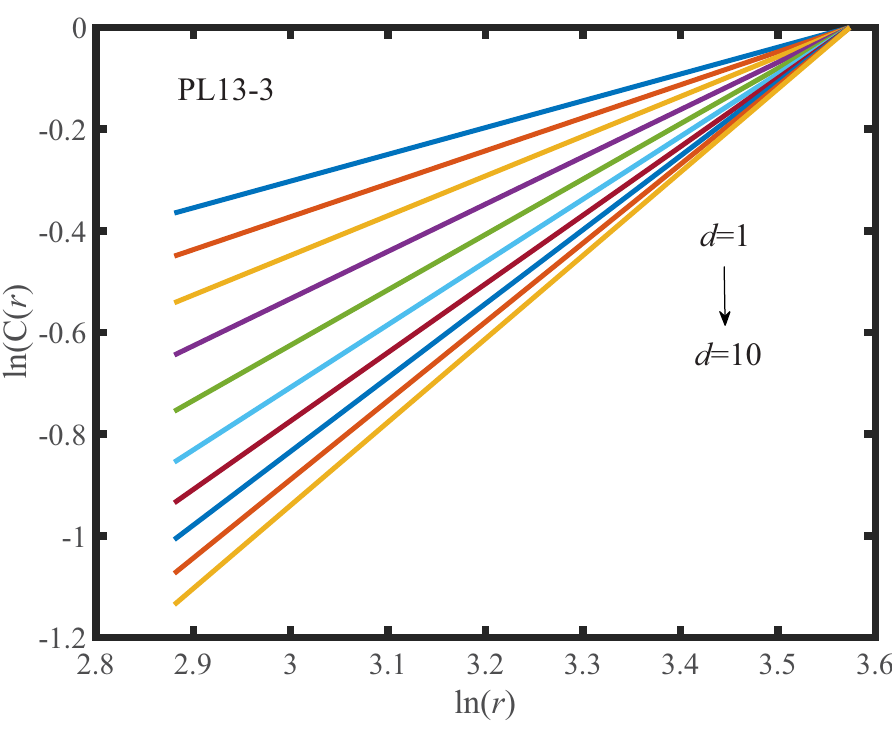
Fig 34. Double logarithmic curve of correlation dimension of the PL13-3.